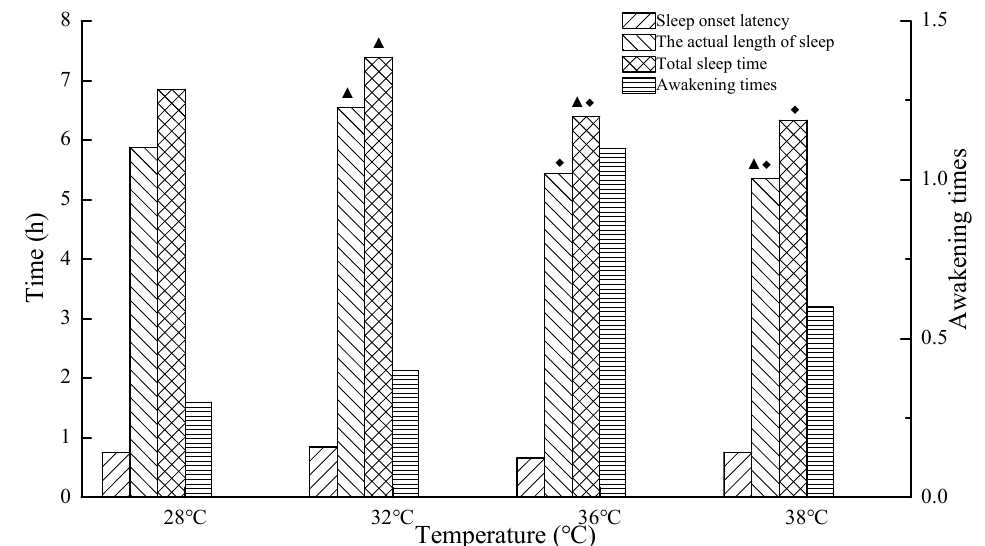
Figure 3. Sleep onset latency, actual length of sleep, total sleep time, and awakening time at 28 °C, 32 °C, 36°C, and 38°C (The legend ▲ indicates that there is a significant difference compared with 28 °C ( p < 0.05), the legend ◆ indicates that there is a significant difference compared with 32 °C ( p < 0.05)).